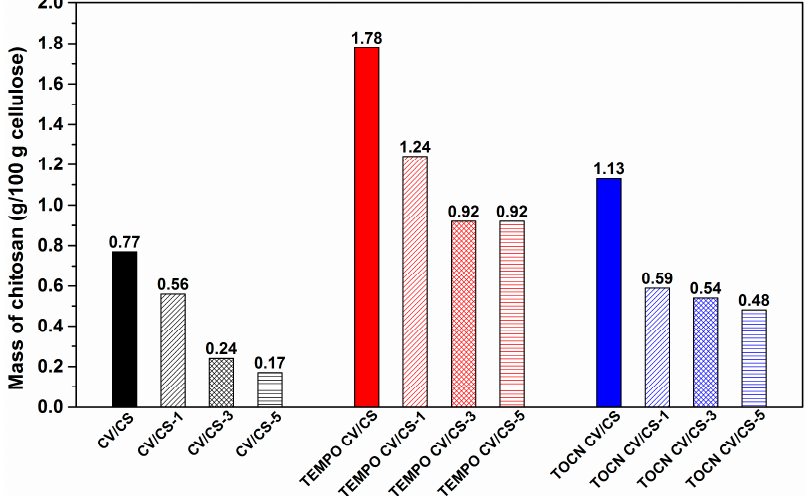
Figure 6. The chitosan content in the chitosan functionalized viscose fabrics after one, three and five washing cycles.